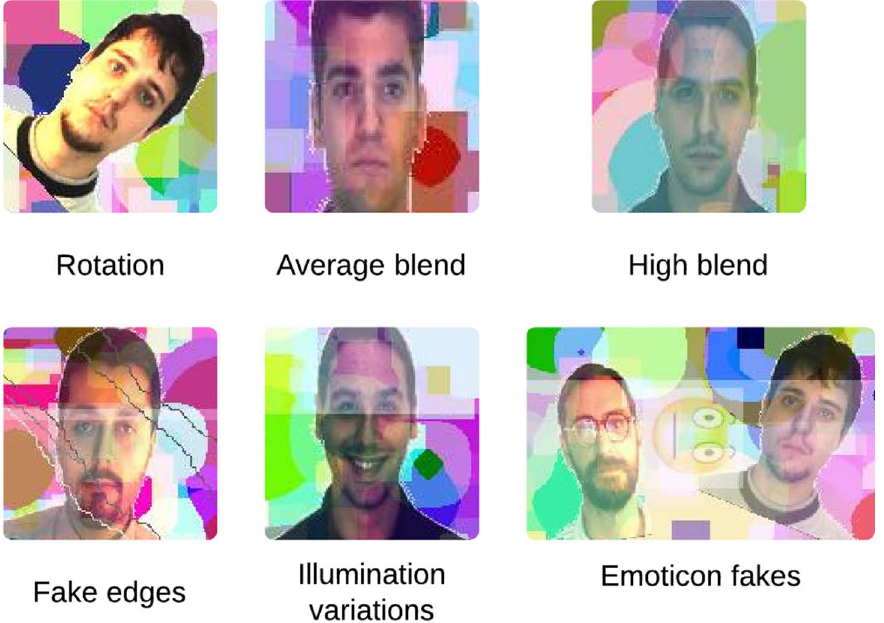
Figure 3. Distortions involved in the FR-CAPTCHA generation process.